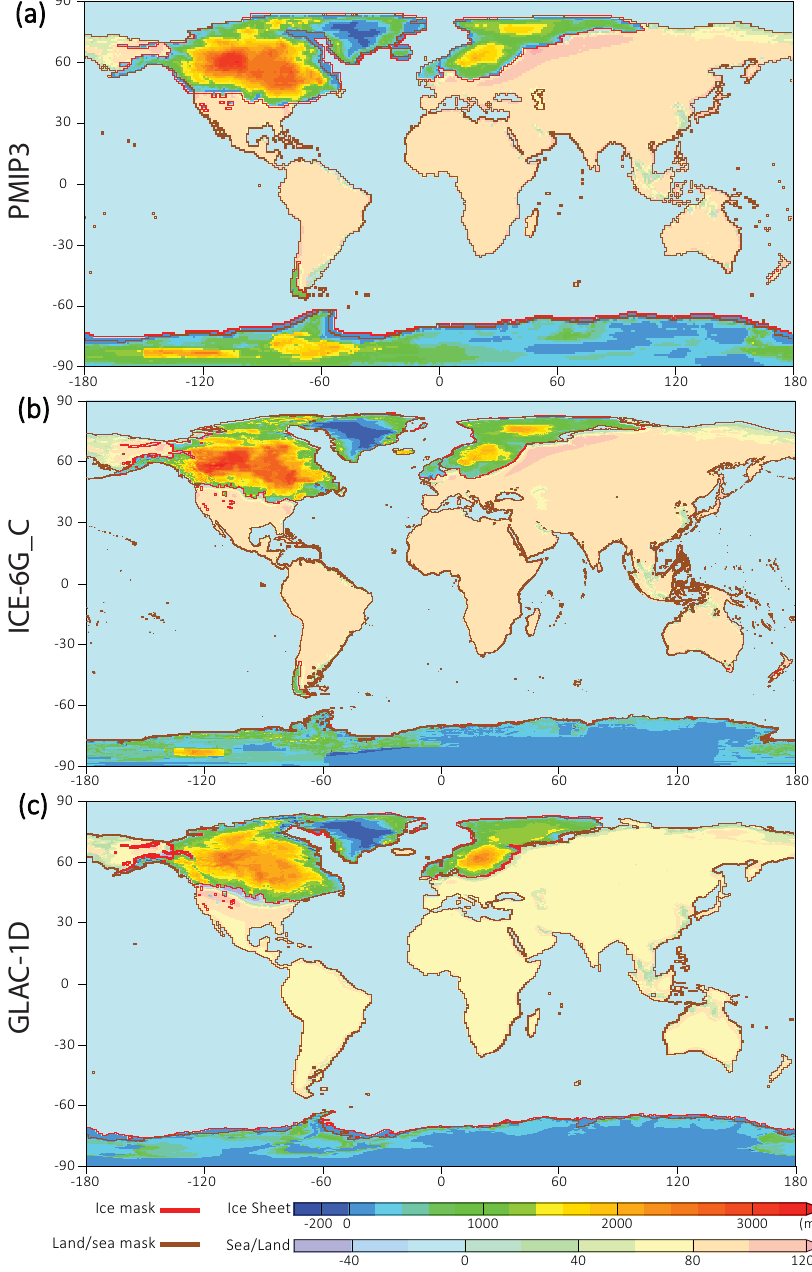
Figure 1. LGM ice-sheet reconstructions. (a) PMIP3, (b) ICE_6G-C, (c) GLAC-1D. Bright colours show the LGM – modern altitude anomaly over the LGM ice sheets; pale colours show the altitude anomalies outside the ice sheets, both in metres. The ice-sheet and land–sea masks are outlined in red and brown,